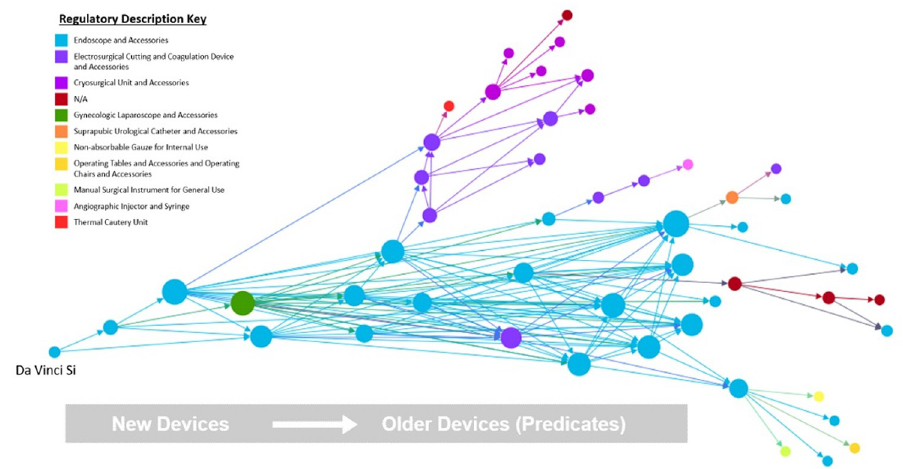
Fig 4. Da Vinci Si trace with devices color-coded by regulatory